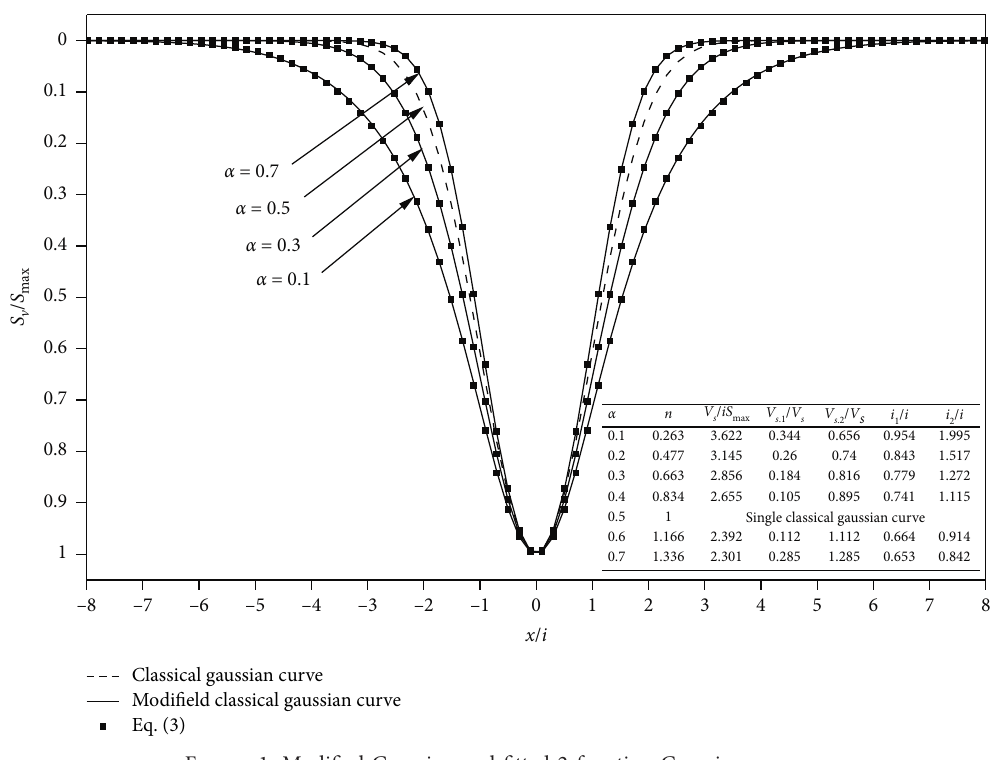
Figure 1: Modified Gaussian and fitted 2-function Gaussian